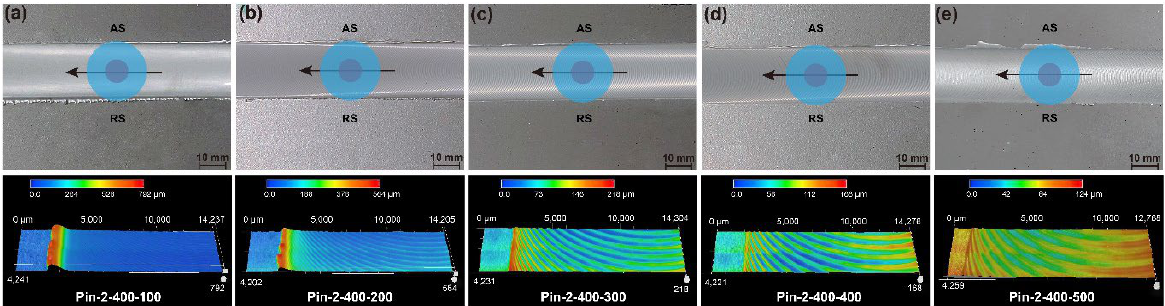
Figure 4. Surface morphologies ( a ) Pin-2-400-100, ( b ) Pin-2-400-200, ( c ) Pin-2-400-300, ( d ) Pin-2-400- 400, and ( e ) Pin-2-400-500.